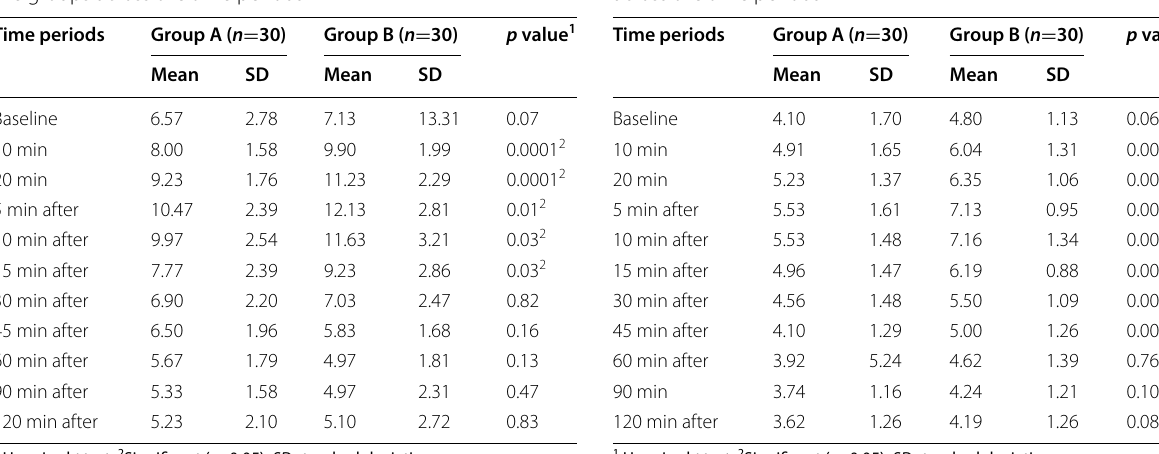
Table 2 Comparison of central venous pressure (CVP) between the groups across the time periods